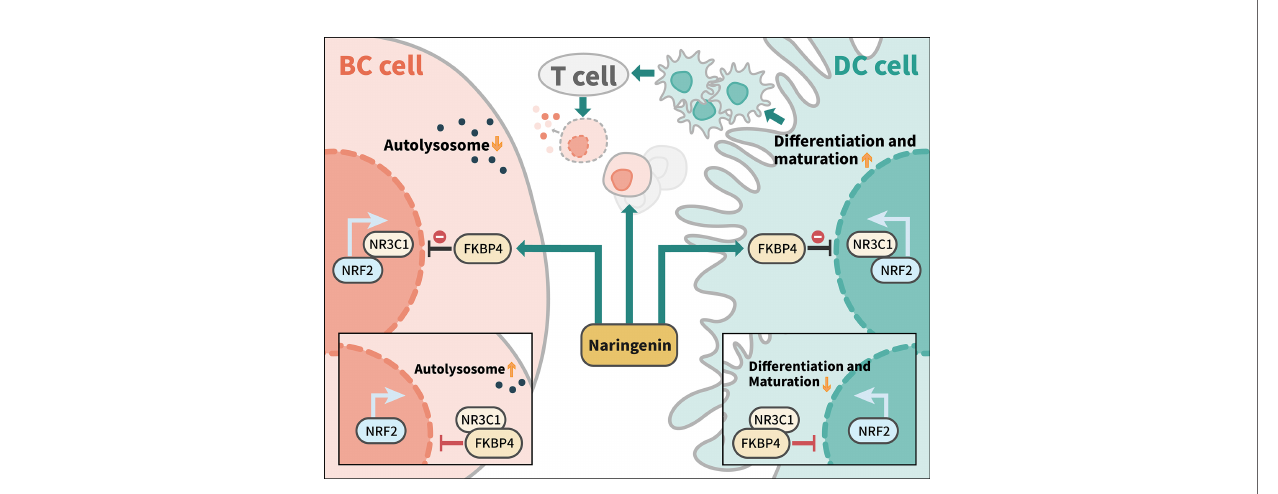
FIGURE 7 | Model of naringenin-mediated inhibition of autophagy and cell proliferation and promotion of DC differentiation and maturation through FKBP4/NR3C1/ NRF2 signaling pathway. Naringenin inhibits FKBP4 protein, thus releasing and inducing NR3C1 protein to bind to NRF2 protein, leading to autophagy and proliferation inhibition of BC cells, as well as differentiation and maturation promotion of DC. Among tumor microenvironment, naringenin might promote T cells to kill breast cancer cells by enhancing the antigen presentation function of DC